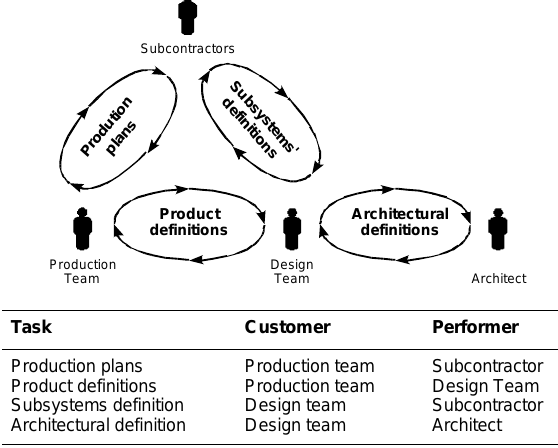
Figure 4 Network of commitments among supply chain